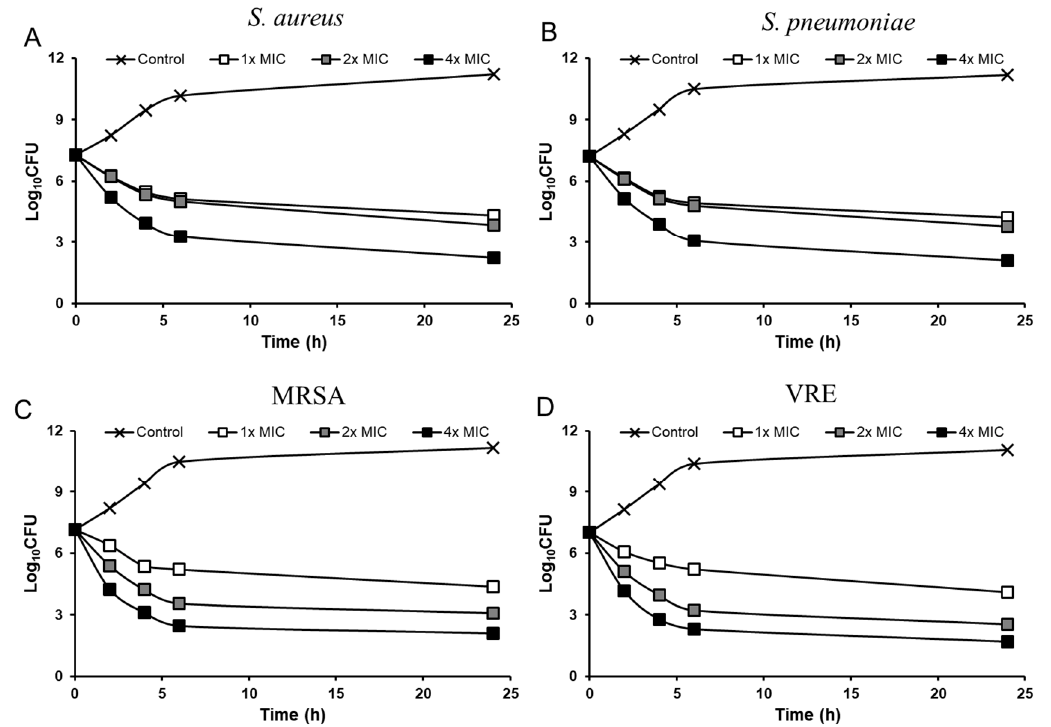
Figure 2. Time ‐ kill curves of coralmycin A. The MIC values (mg/L) of coralmycin A against S. aureus Giorgio ( A ), S. pneumoniae ATCC49619 ( B ), MRSA CCARM 3167 ( C ), and VRE 3 ( D ) were 0.003, 0.01, 0.01, and 0.5, respectively.